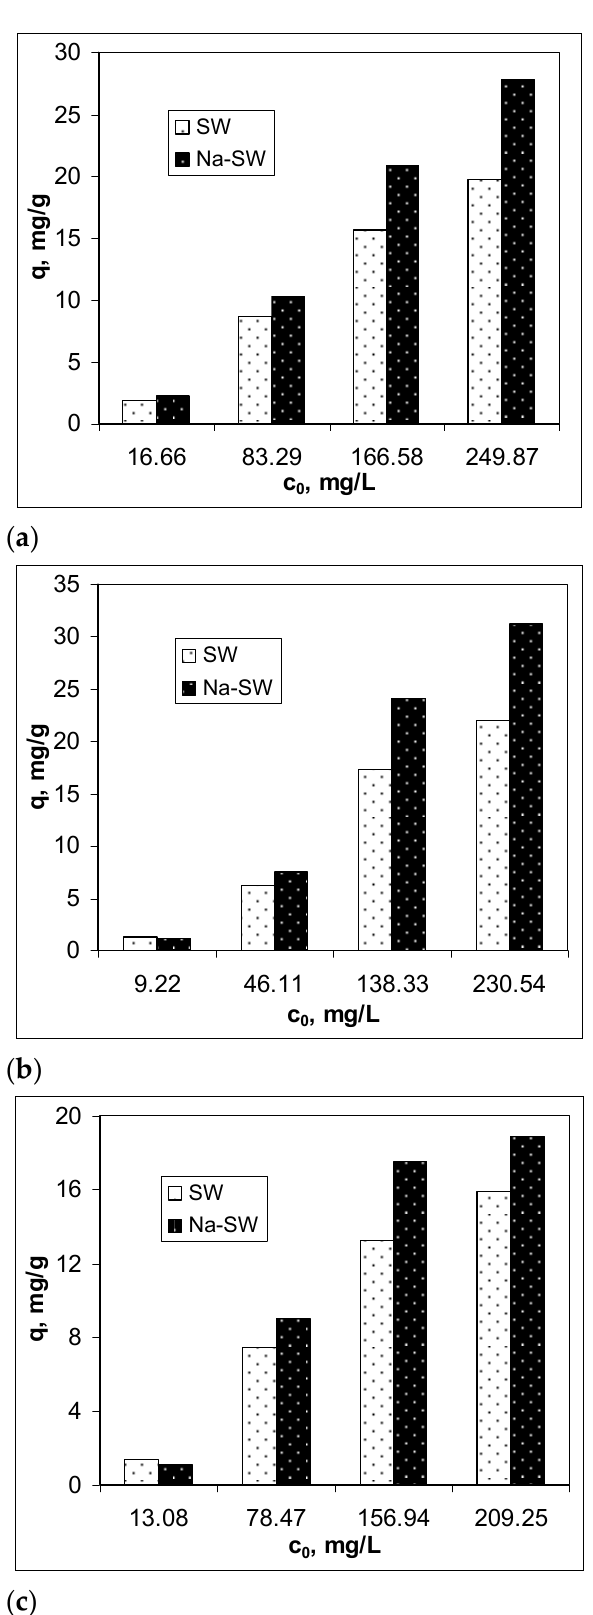
Figure 3. Comparison of biosorption capacities of SW and Na-SW for different initial concentrations of Pb(II) ( a ), Cd(II) ( b ), and Zn(II) ( c ).